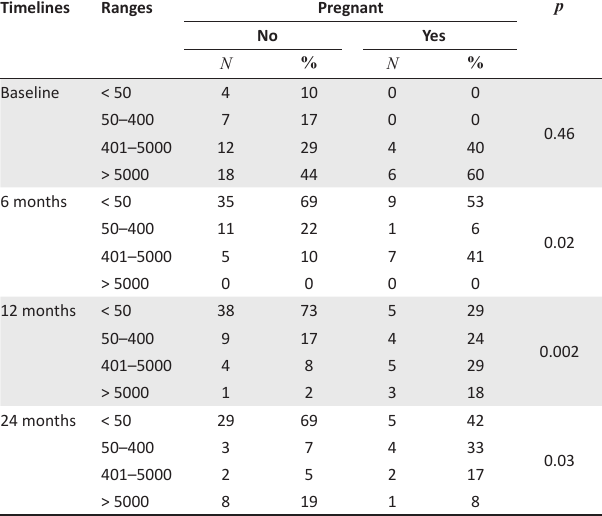
TABLE 5: Associations of viral load and pregnancy status.